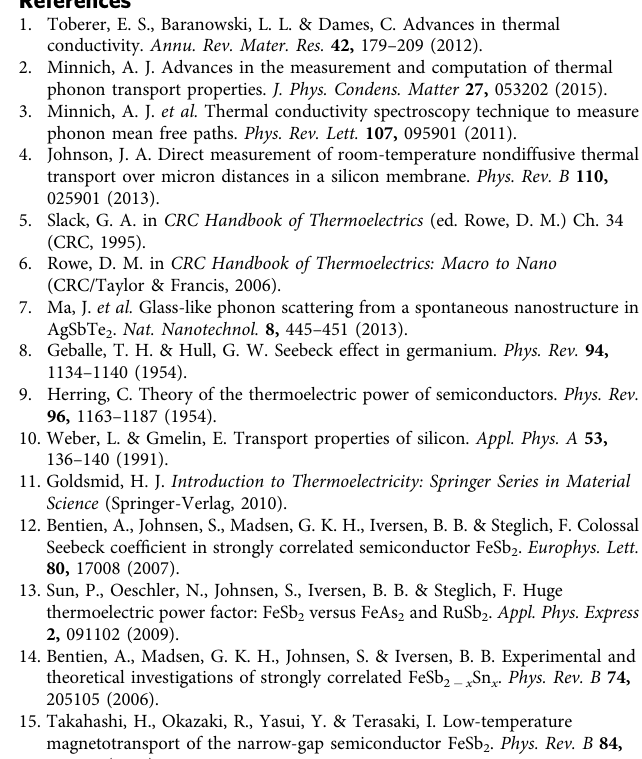
in Fig. 3c. The linear relation between l s and l k ( l s ¼ g l k ) yields a simple expression for the phonon drag’s dimensionless figure of merit z p T ¼ S ph 2 s T k (cid:2) 1 ¼ Al s n m (cid:2) 1 T (cid:2) 1 ( s ¼ ne m , A ¼ 3 b 2 evC (cid:2) 1 g (cid:2) 1 ), which can be improved by increasing l s and m *. Whereas z p T is restricted to a low value ( o 1/4)